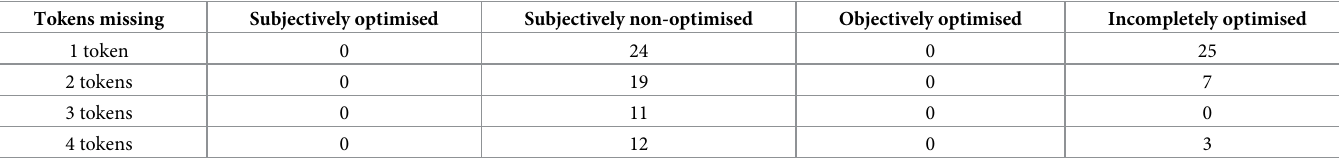
Table 3. Distribution of participants who had CAEP response absent for one, two, three or four speech tokens. Tokens